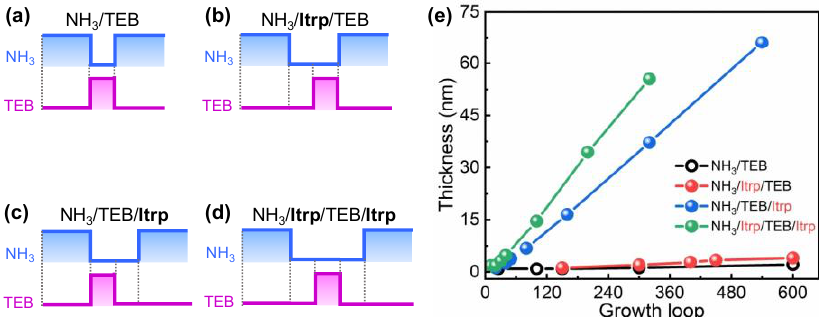
Figure 1. The schematic diagrams of ( a ) NH 3 /TEB, ( b ) NH 3 /Itrp/TEB, ( c ) NH 3 /TEB/Itrp and ( d ) NH 3 /Itrp/TEB/Itrp. ( e ) the thickness variations of h-BN thickness with growth loops under four FME modes.